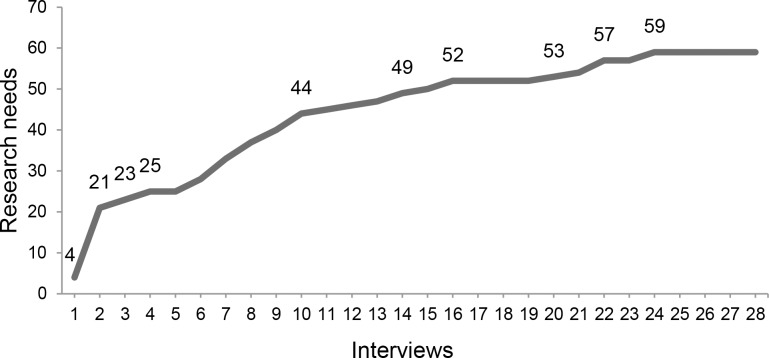
Saturation curve of research needs.Saturation was reached after 24 interviews.